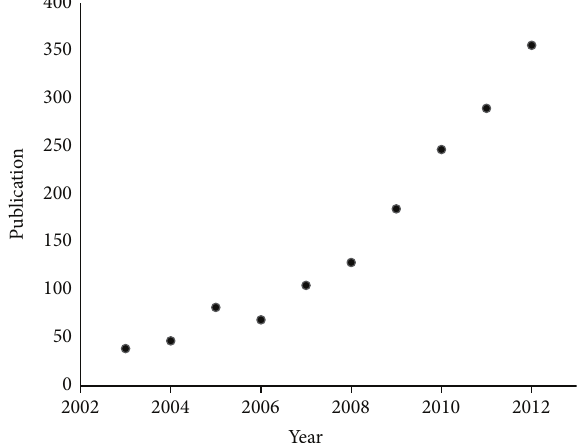
Figure 5: Increase in number of MRM publications in PubMed over the past